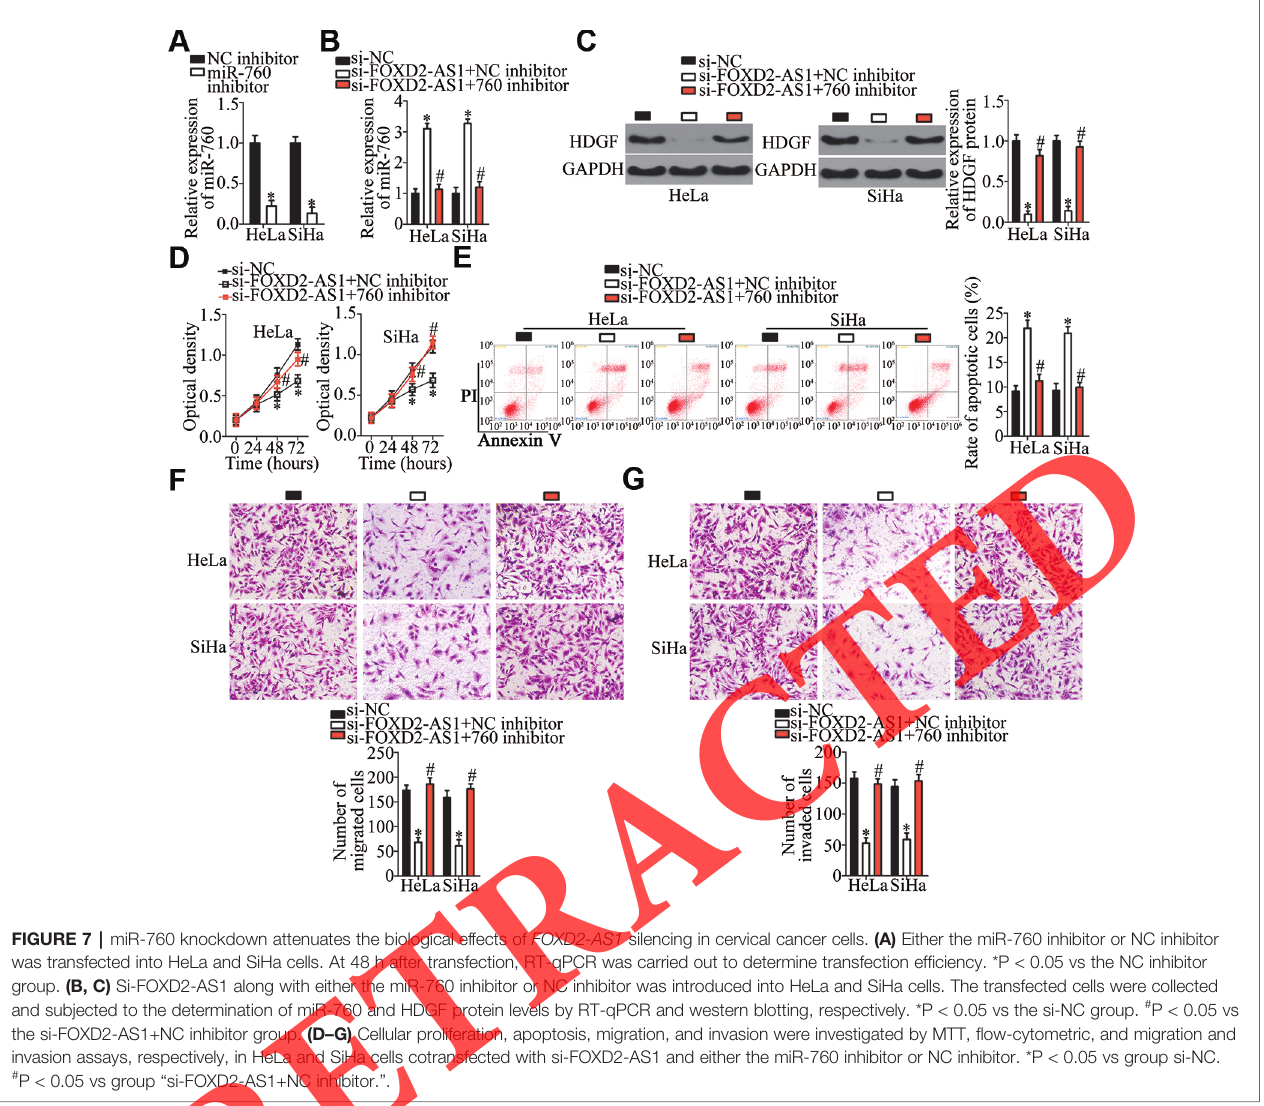
FIGURE 7 | miR-760 knockdown attenuates the biological effects of FOXD2-AS1 silencing in cervical cancer cells. (A) Either the miR-760 inhibitor or NC inhibitor was transfected into HeLa and SiHa cells. At 48 h after transfection, RT-qPCR was carried out to determine transfection ef fi ciency. *P < 0.05 vs the NC inhibitor group. (B, C) Si-FOXD2-AS1 along with either the miR-760 inhibitor or NC inhibitor was introduced into HeLa and SiHa cells. The transfected cells were collected and subjected to the determination of miR-760 and HDGF protein levels by RT-qPCR and western blotting, respectively. *P < 0.05 vs the si-NC group. # P < 0.05 vs the si-FOXD2-AS1+NC inhibitor group. (D – G) Cellular proliferation, apoptosis, migration, and invasion were investigated by MTT, fl ow-cytometric, and migration and invasion assays, respectively, in HeLa and SiHa cells cotransfected with si-FOXD2-AS1 and either the miR-760 inhibitor or NC inhibitor. *P < 0.05 vs group si-NC. # P < 0.05 vs group “ si-FOXD2-AS1+NC inhibitor. ”